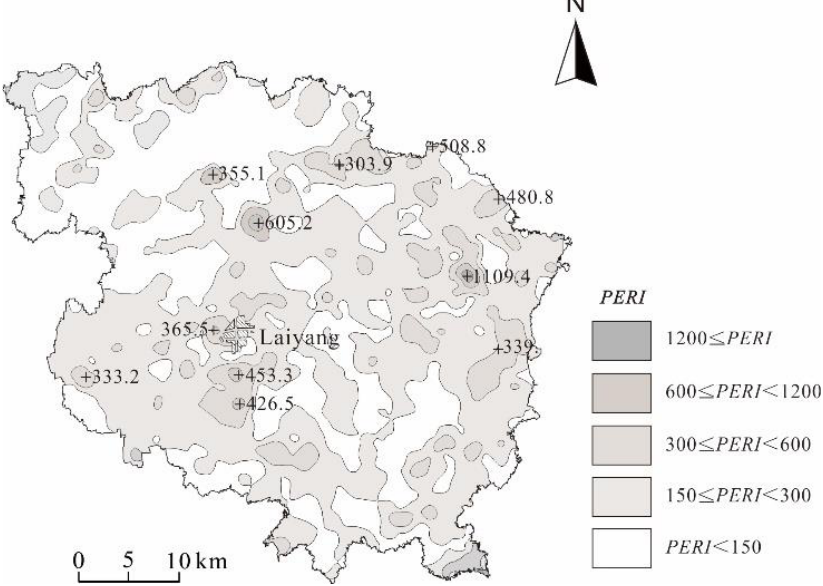
Figure 9. Spatial distributions of the potential ecological risk index ( PERI ). Note: + denotes the maximum PERI values.